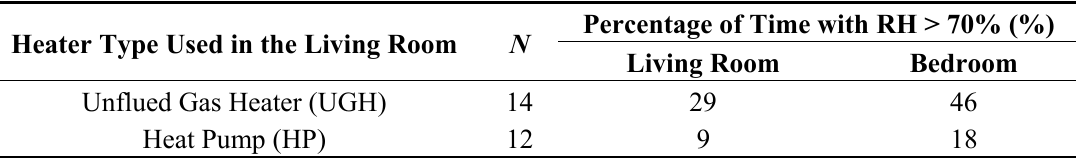
Table 2. Percentage of time with the wall RH above 70% in the living rooms and in the